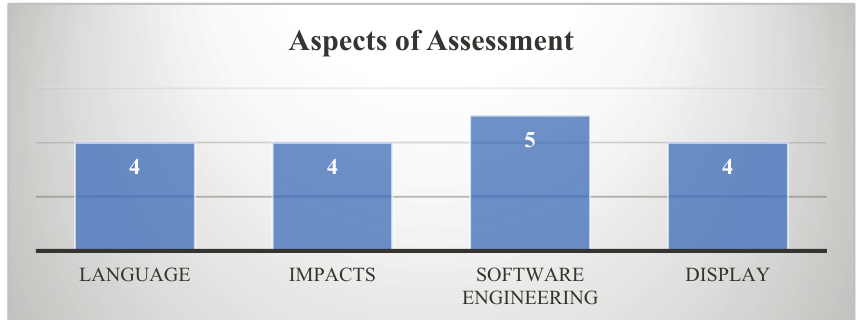
Figure 5: The results of the assessment of the prototype by IT